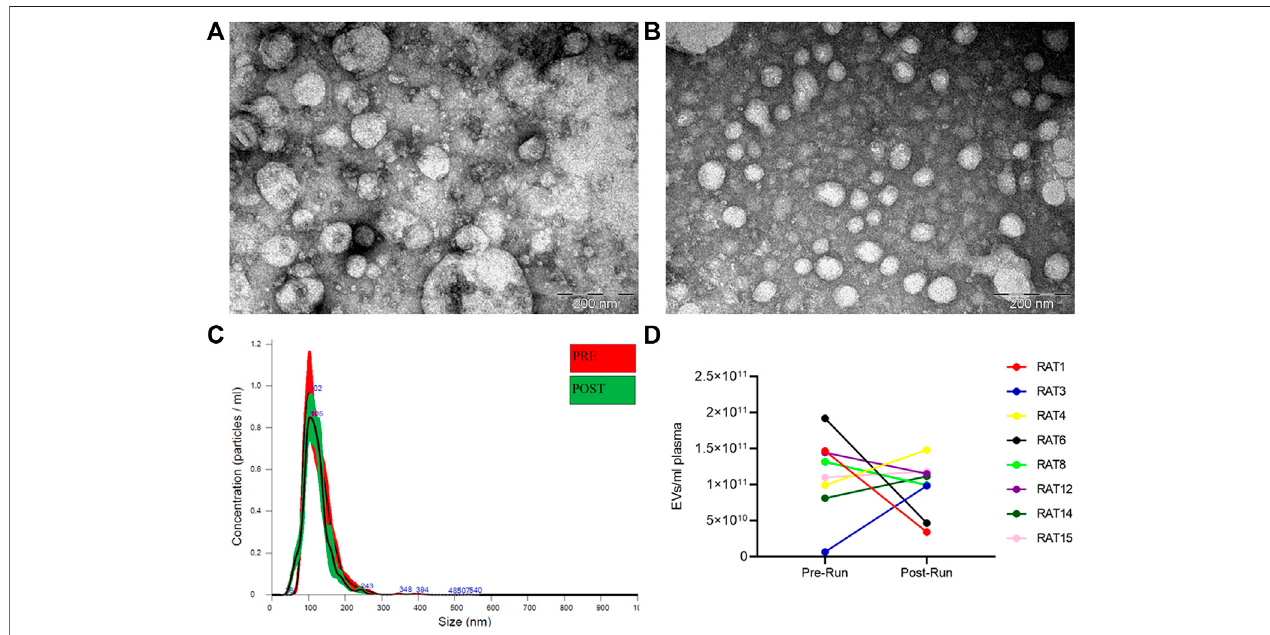
FIGURE 2 | Characteristics of EVs released in plasma during forced wheel running exercise. (A) Representative TEM image of Pre-RUN plasma EVs. (B) RepresentativeTEMimageofPost-RUNplasmaEVs. (C) QuantityandsizedistributionofPre-RUNandPost-RUNplasmaEVsassessedbyNTA(arepresentativecase). (D) Paired dot plots show the number of particles in Pre-RUN and corresponding Post-RUN plasma samples determined by NTA.